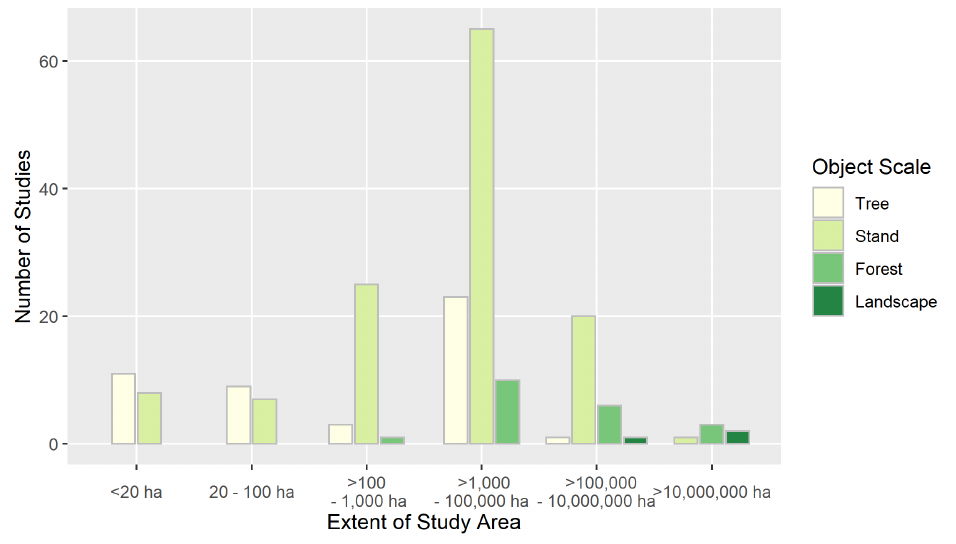
Figure 10. Size of study areas in relation to the observed object scale. Note that some studies